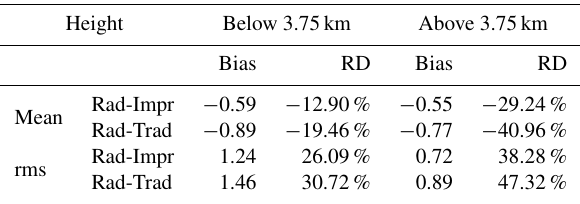
Table 5. The rms and mean of differences between tomography- derived and COSMIC-derived water vapor density above 3.75km and blow 3.75km, respectively (gm − 3 ) . “RD” represents the rela- tive